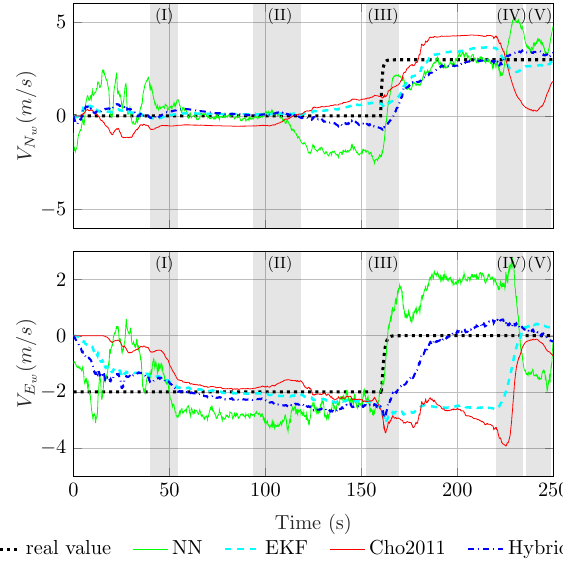
Figure 6. Simulation using the airship nonlinear model with realistic sensor noise: estimated wind velocity components in NE